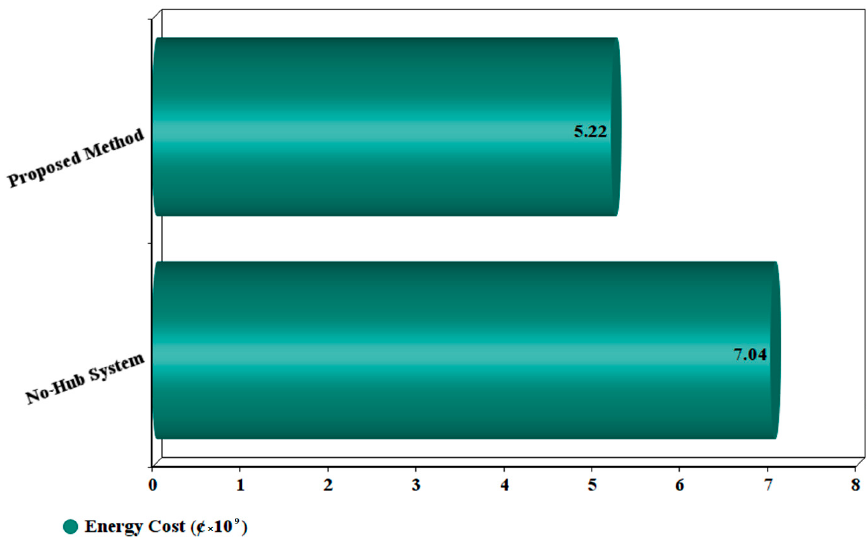
Figure 10. The energy cost for two methods: (1) proposal (2) no hub.